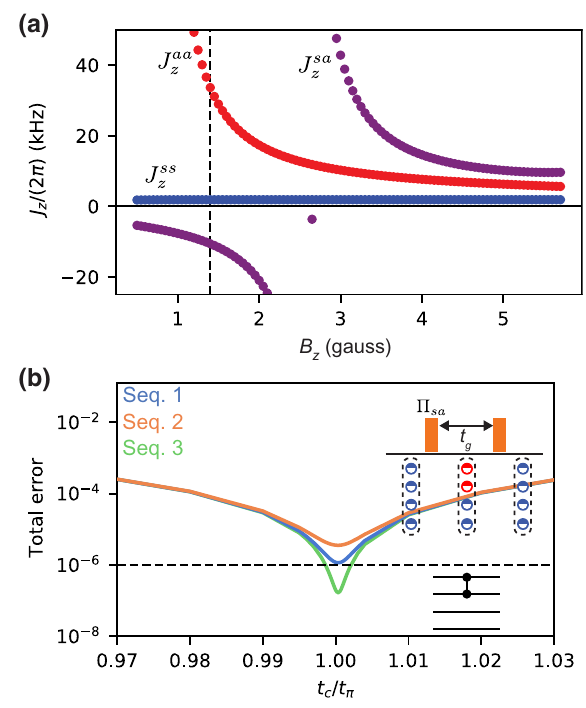
FIG. 7. (a) Strength of the J z terms in Eqs. (6)–(8) as a func- / J ss = − 2 tion of B z , moving along the lower branch of the J ss z and J sa both pass through Förster reso- contour in Fig. 6(a). J aa z z nances, enabling wide control of their magnitude. At B z = 1.39 = 2 π × 33.6 kHz, corresponding to t = G (dashed line), J aa π z 3.7 μ s. (b) Error in a four-qubit array during a two-qubit gate operation, as a function of the gate duration t g . The blue and orange curves correspond to sequences 1 and 2, while the green curve corresponds to sequence 3 [see text and Fig.